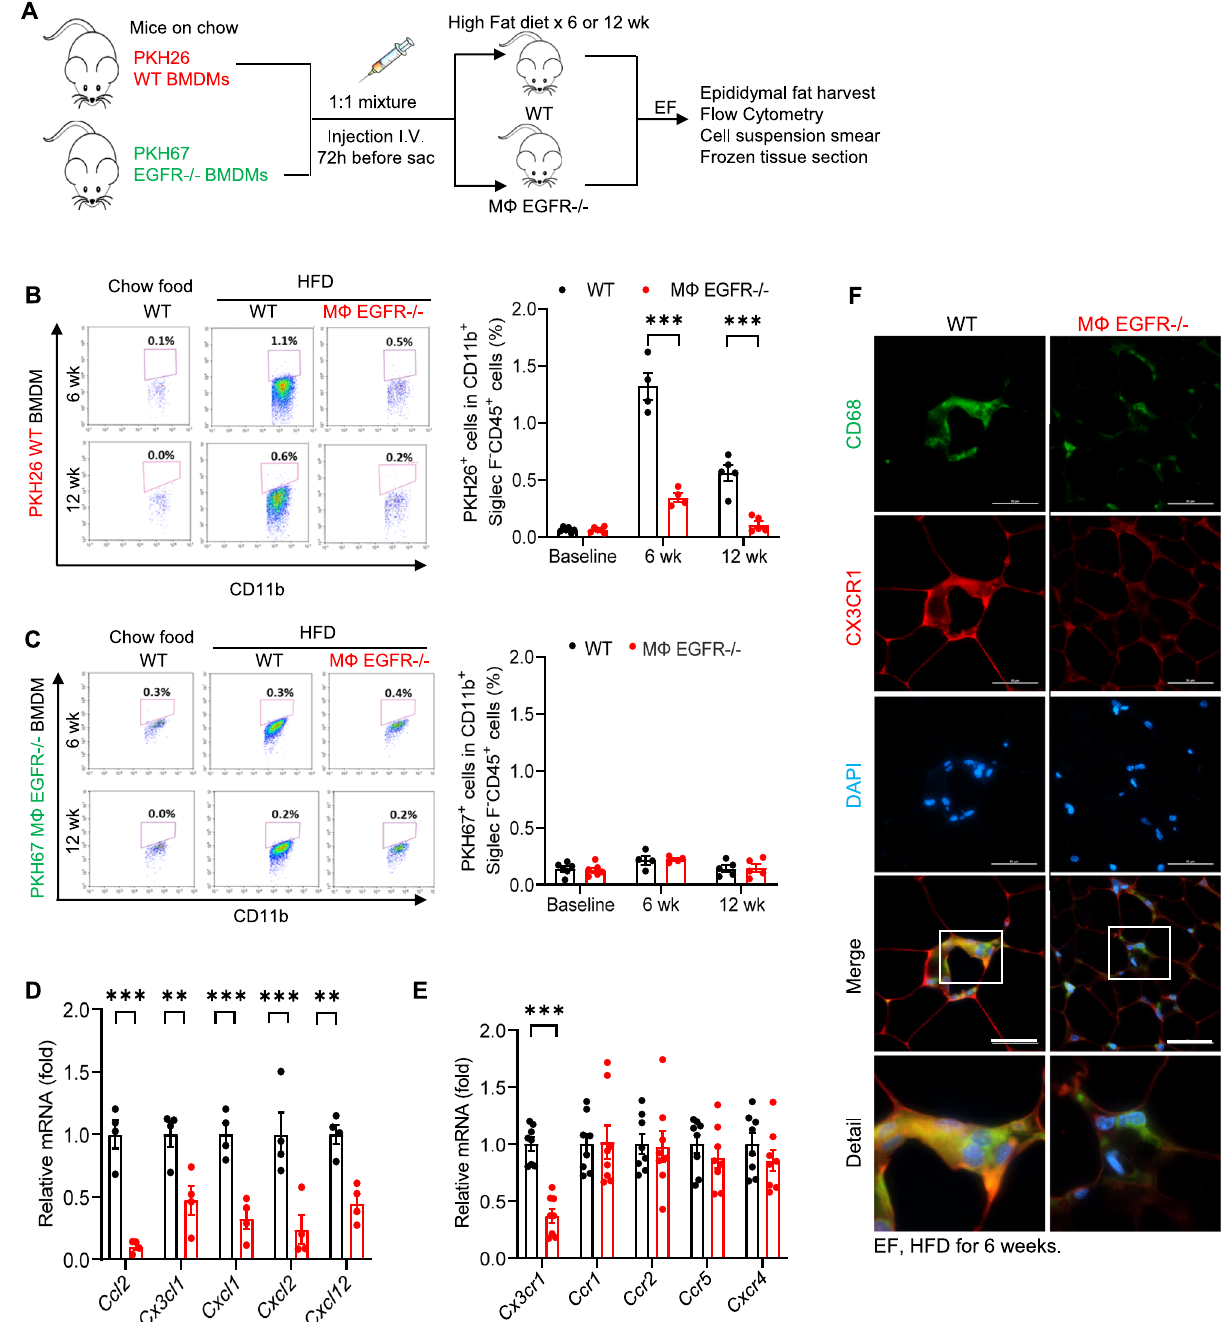
diet-inducedobesity. WTandM Φ EGFR − / − micewerefedtheHFDfor6or12weeks and EF was used for experiment. A Schematic of experimental protocol. B WT BMDMshadgreaterEFin fi ltrationat6weeksthanat12weeksinWTrecipientmice. In fi ltration into EF was markedly decreased in M Φ EGFR − / − recipients at both time points. N =4 and 5 and 6. C The in fi ltration of EGFR − / − BMDMs in EF was